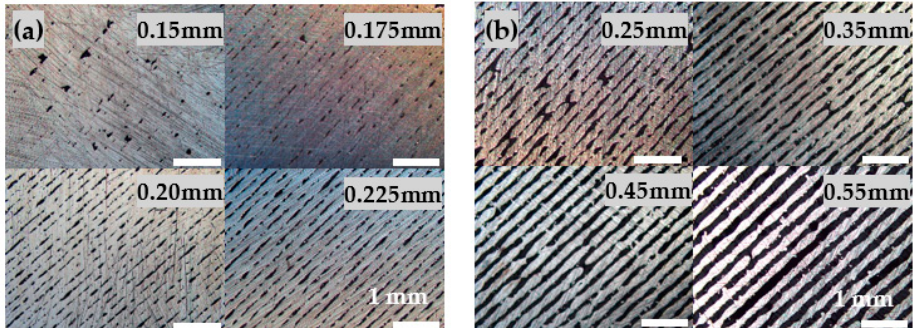
Figure 2. Formation of single walls in dependence of increasing hatch distance. ( a ) Insufficiently isolated hatch distances (0.15 mm to 0.225 mm) lead to not separated single walls. ( b ) As the hatch distances increases from 0.25 mm to 0.55 mm, single walls occur.